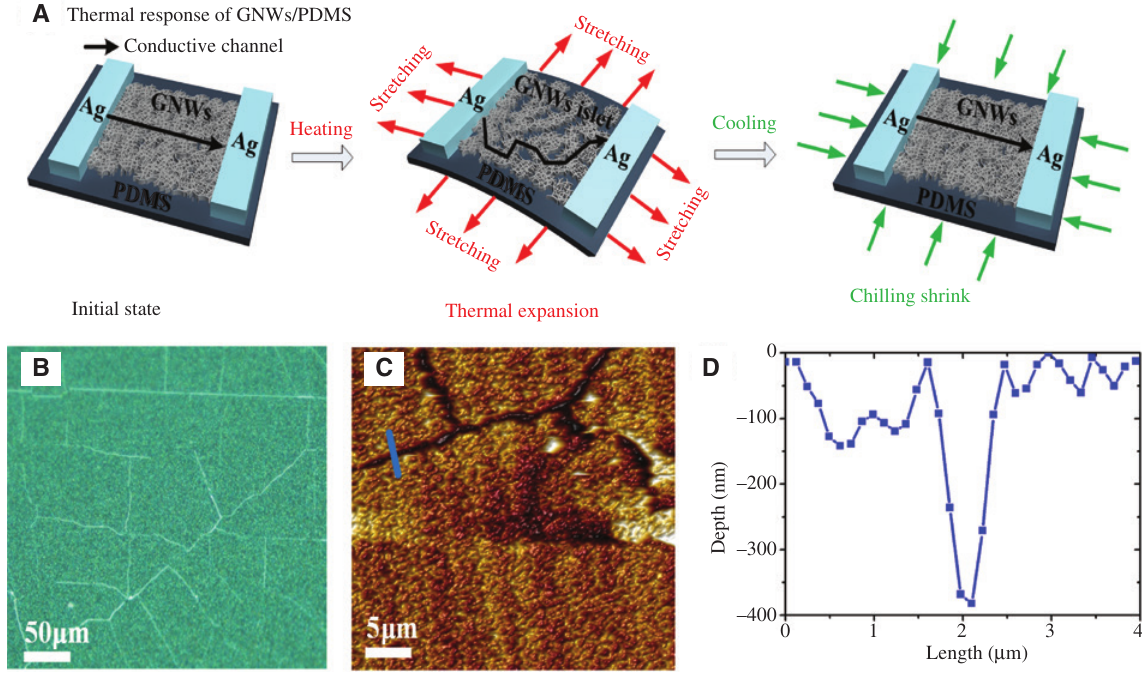
Figure 4: Schematic diagram of thermal response of the GNWs/PDMS. (A) Schematic diagram of the thermal response of GNWs/PDMS, (B and C) optical microscopy and AFM images of GNW/PDMS surface at 45 ° C, and (D) AFM cross-section profile of the crack region in